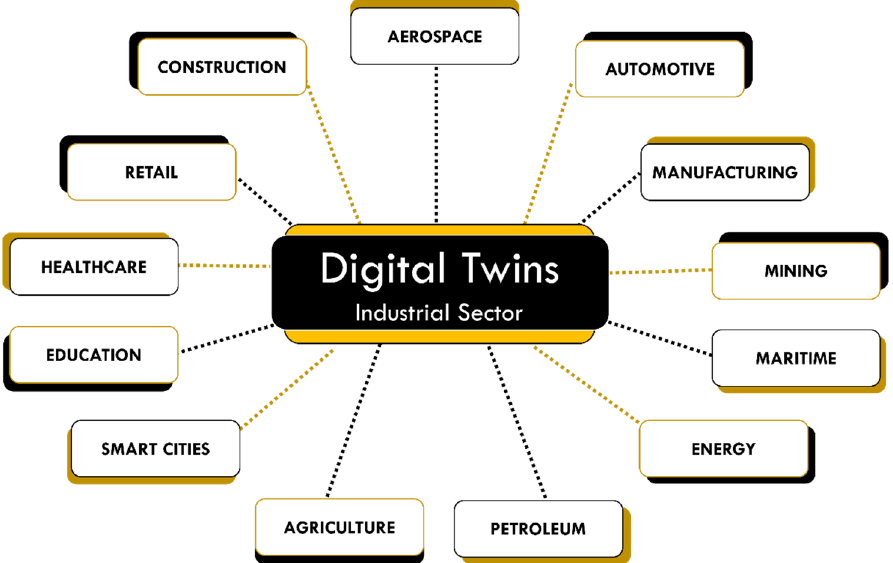
Figure 2. Different industrial sectors where DT has found its applications.